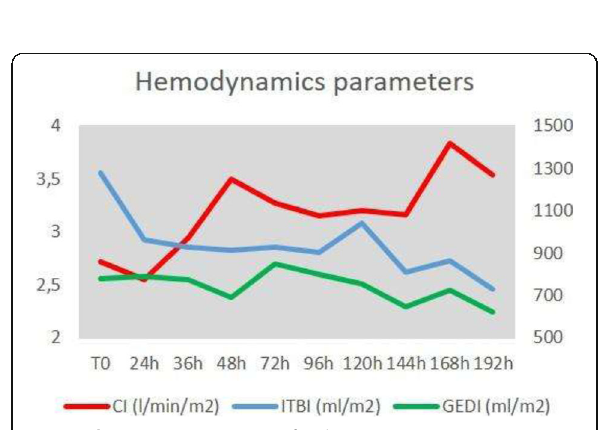
Fig. 2 (abstract 0301). See text for